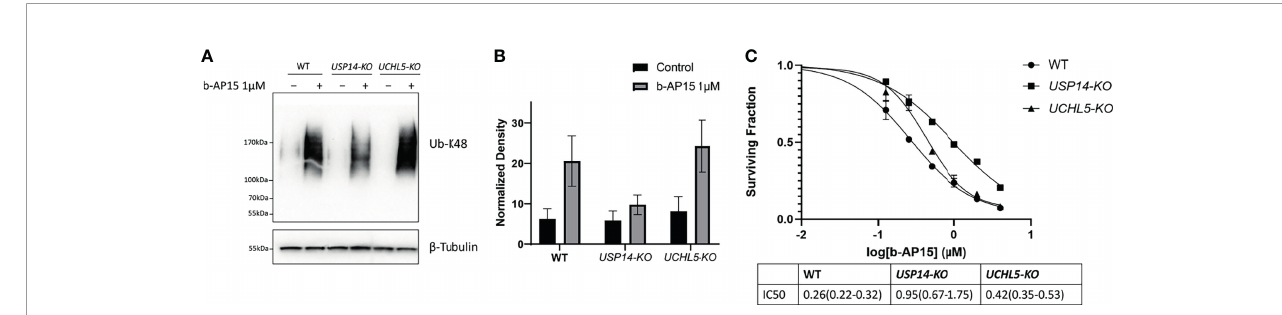
FIGURE 6 | b-AP15 cytotoxicity is partially mediated by USP14. (A) Parental HCT116, USP14-KO , and UCHL5-KO were exposed to either b-AP15(1µM) or DMSO for 8 hours. Whole cell lysates were obtained and probed for K48 polyubiquitin or b -tubulin (B) K48 polyubiquitin smears normalized to the corresponding b -tubulin bands. Each bar is the average normalized density from three independent samples +/- SD. The differences between b-AP15 and DMSO groups across all cell-types are not statistically signi fi cant (C) The sensitivity of parental and mutant cell lines to b-AP15 was studied using the MTT assay. Points represent the mean of four replicates +/- SD. The estimated and 95% con fi dence interval for the IC50s are listed in the table below the